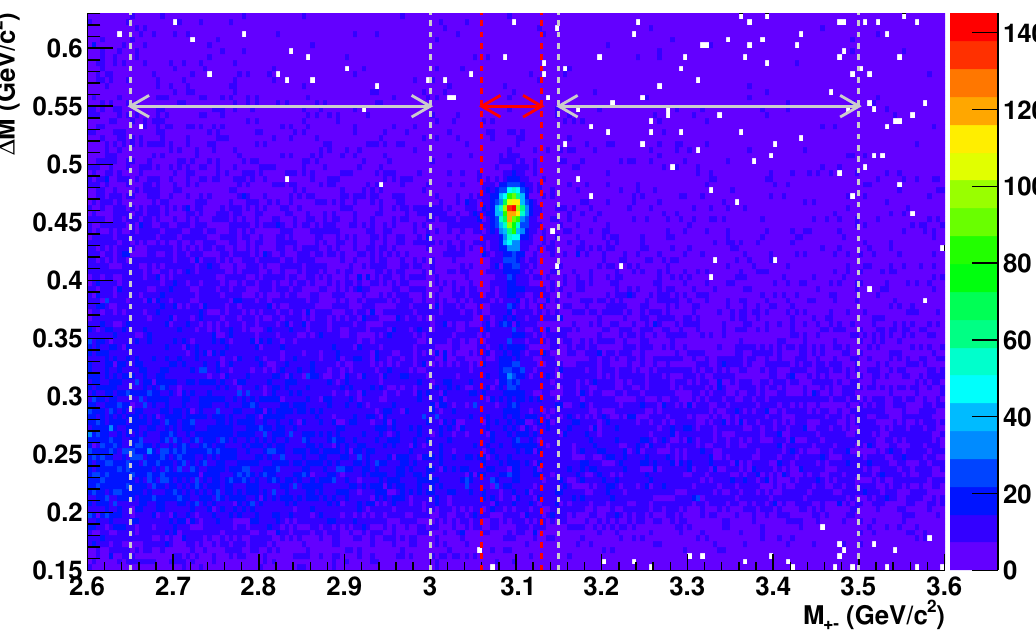
Figure 2 . Scatter plot of the invariant mass difference ( ∆ M ) versus the invariant mass of the two tracks ( M + − ) for the data sample after the event selection combined with e + e − and µ + µ − pairs. The J/ψ signal region and J/ψ sideband regions are drawn by the red and gray dotted line,